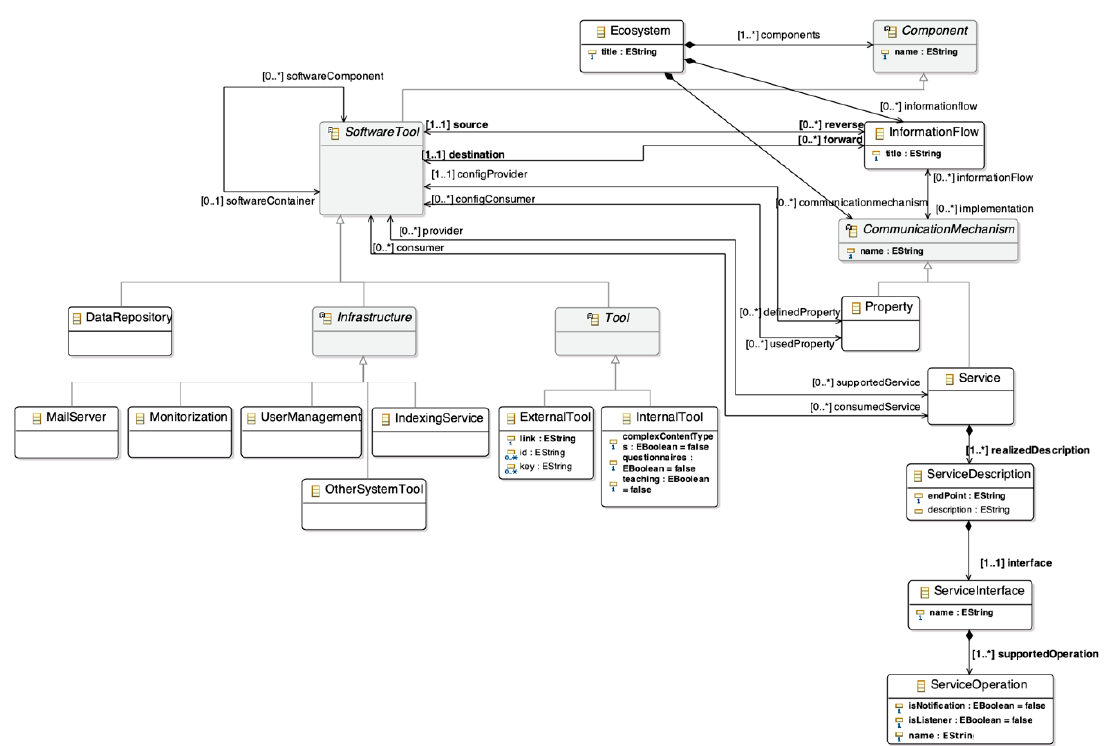
Figure 3. Software components and information flows in the learning ecosystem meta-model. Based